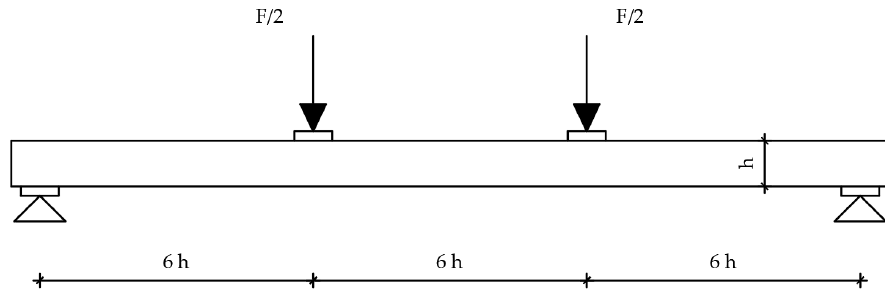
Figure 10. Four-point bending test setup.